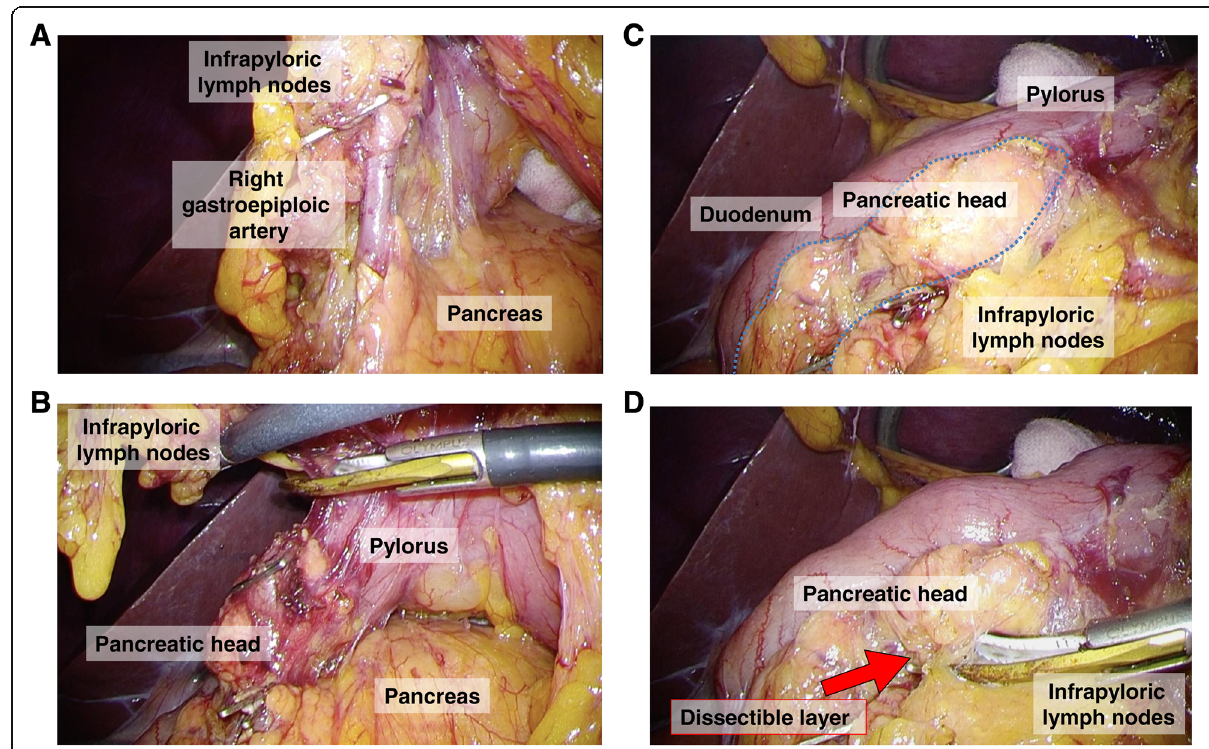
Fig. 2 Operative views during infrapyloric lymph node dissection. a View of the infrapyloric area. Right gastroepiploic vessels were dissected and cut during the infrapyloric lymph node dissection in close proximity to the pancreas. b , c A part of the pancreatic head could not be separated from the first part of the duodenal wall during the infrapyloric lymph node dissection. Irregular adhesion of the pancreatic head to the pylorus made it difficult to dissect the infrapyloric lymph node. d We performed meticulous lymph node dissection by accurately tracing the dissectable layer, created by adequate countertraction. Subsequently, the right gastroepiploic vessels were cut and infrapyloric lymph node dissection was